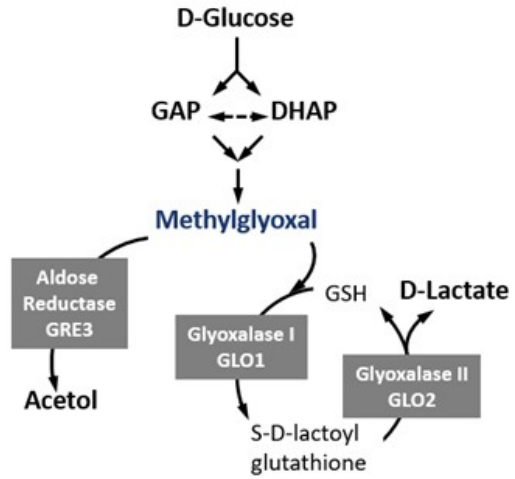
Figure 1. Overview of methylglyoxal (MGO) metabolism. MGO, the most reactive glycating agent is primarily formed from the spontaneous decomposition of the phosphate group of glyceraldehyde 3 ‐ phosphate (GAP) and dihydroxiacetone phosphate (DHAP). It may also arise from the oxidation of aminoacetone in the catabolism of L ‐ threonine from the oxidation of ketone bodies and the oxidation of acetone. MGO is catabolised via the glyoxalase system (Glo1 and Glo2), resulting in the formation of D ‐ lactate and glutathione, and by aldose reductase Gre3, resulting in acetol formation.